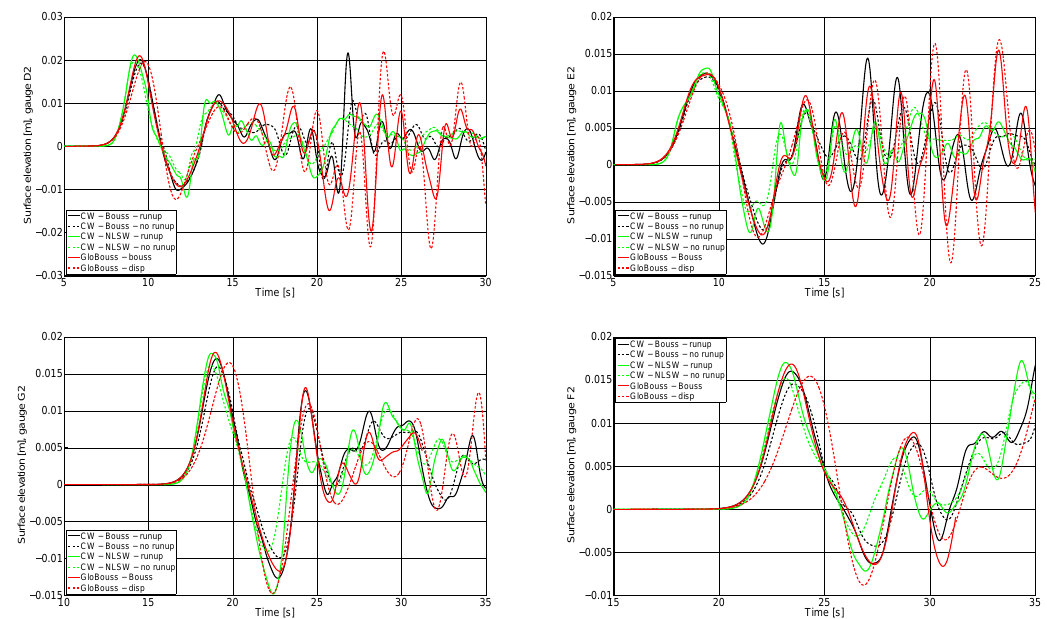
Figure 10. Comparison of the simulated surface elevations for Coulwave and GloBouss under different modeling assumptions. The abbre- viation “CW” refers to the use of Coulwave; “Bouss” refers to the inclusion of both nonlinear and dispersive terms in the numerical model; “disp” refers to running the model in linear dispersive